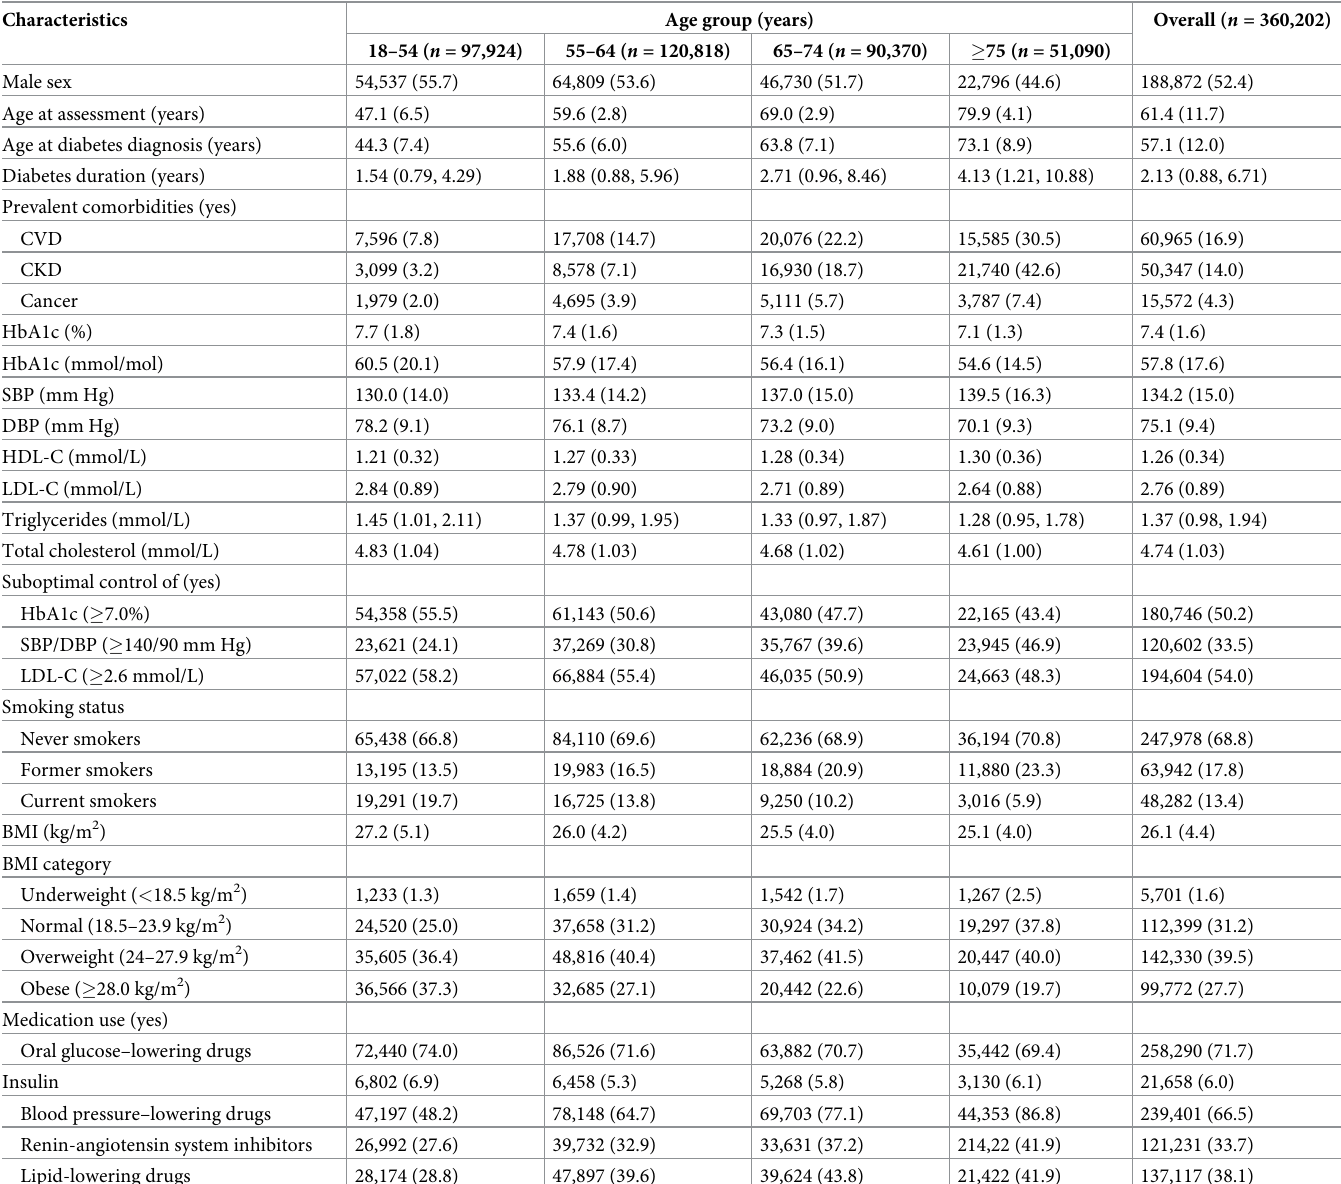
Table 1. Baseline characteristics of people with type 2 diabetes at enrollment in the RAMP-DM.